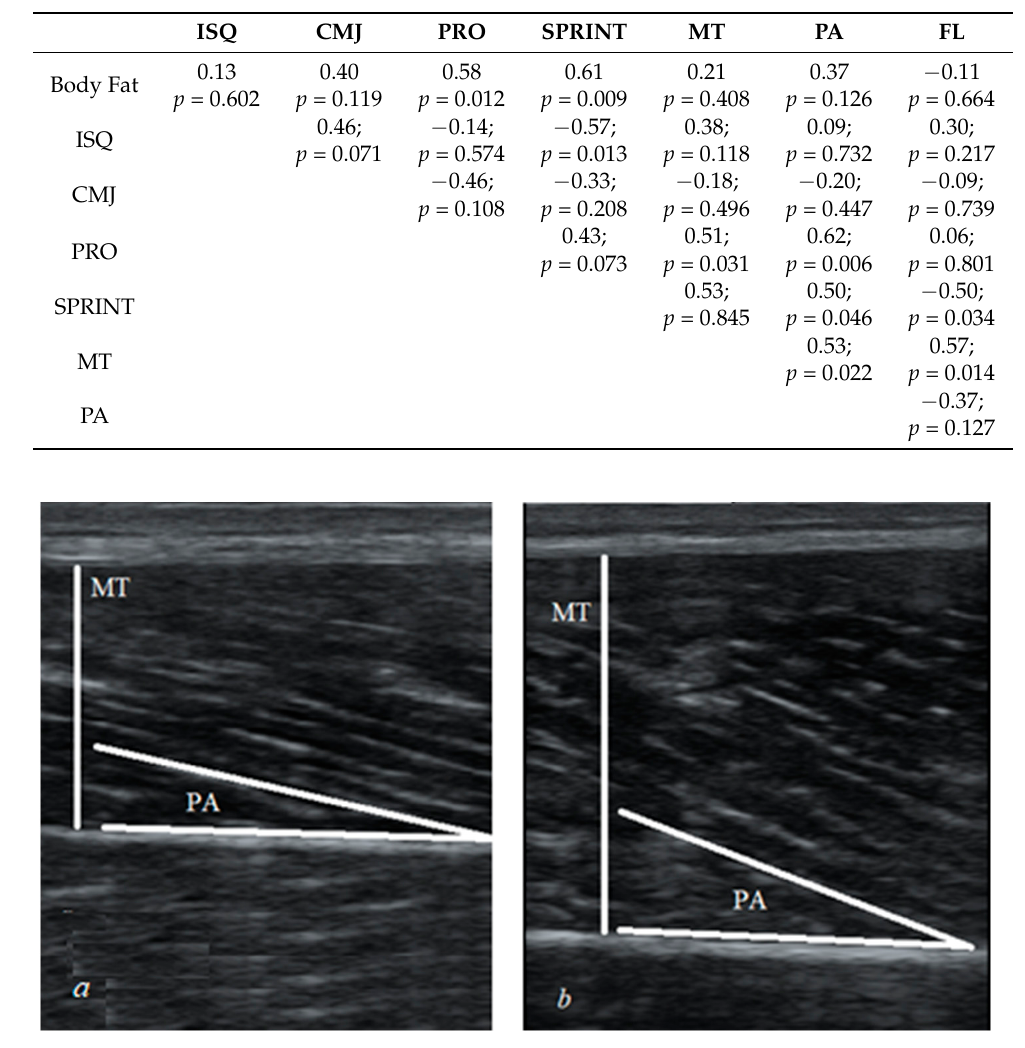
Figure 2. Ultrasound images of the VL (vastus lateralis) of two participants. Subject a and subject b were characterized by different MT and PA. MT = muscle thickness; PA = pennation angle.